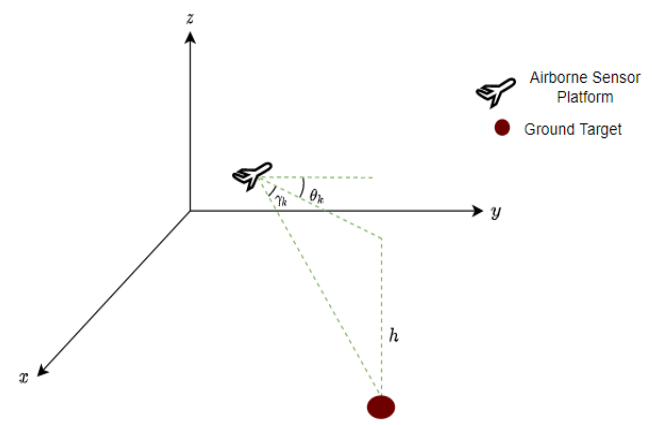
Figure 1. Target-sensor